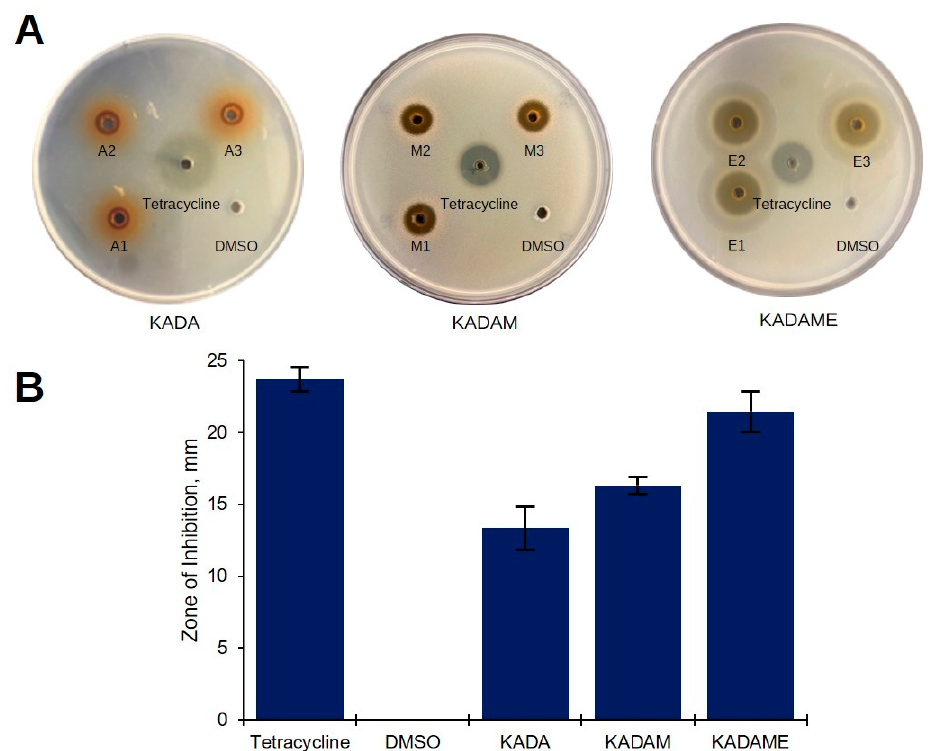
Figure 2. Antibacterial activity of solvent-partitioned extracts against the multidrug-resistant S. aureus . ( A ) Plates of agar well diffusion assay showing the clearing zone when treated with C. cajan seed acetone extract KADA (A1–A3), methanol fraction KADAM (M1–M3), and ethyl acetate fraction KADAME (E1–E3) at 20 mg/well against MDRSA. Tetracycline (0.25 mg/well) and DMSO were used as positive and negative controls, respectively. ( B ) Zones of inhibition of the samples in mm ( ± SD) against S. aureus ATCC BAA-44. Error bars represent the standard deviation.